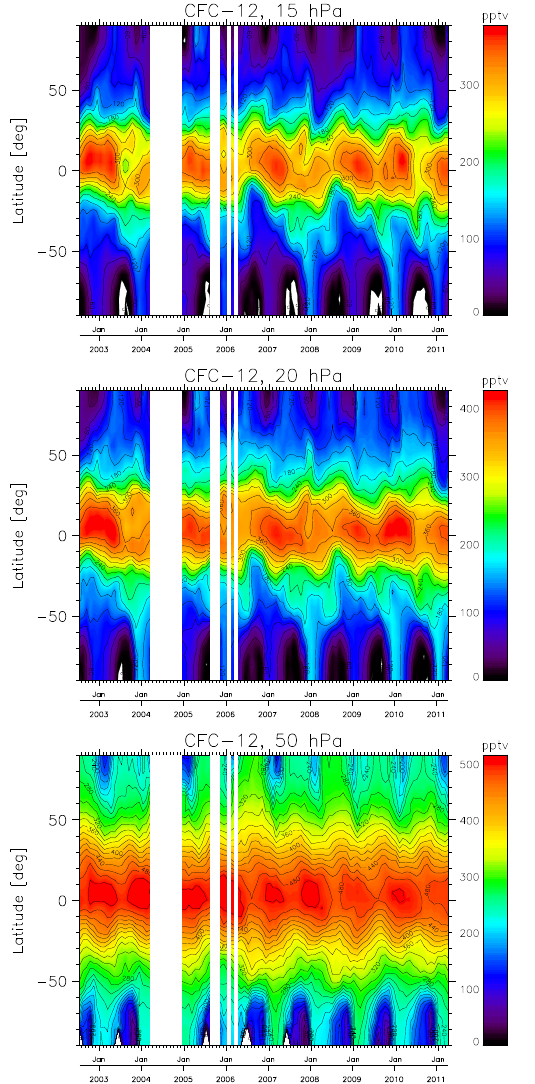
Fig. 9. Time series of CFC-12 as a function of latitude between Fig.9. Timeseriesof CFC-12as afunction of latitudebetween July July 2002 and April 2011 at 15hPa, 20hPa and 50hPa. Details as 2002 and April 2011 at 15 hPa, 20 hPa and 50 hPa. Details as for Figure 6. for Fig. 6. Fig. 8. CFC-12 monthly zonal mean distribution between 200 hPa and 1 hPa in September 2002, December 2003, March 2008, and June 2010.